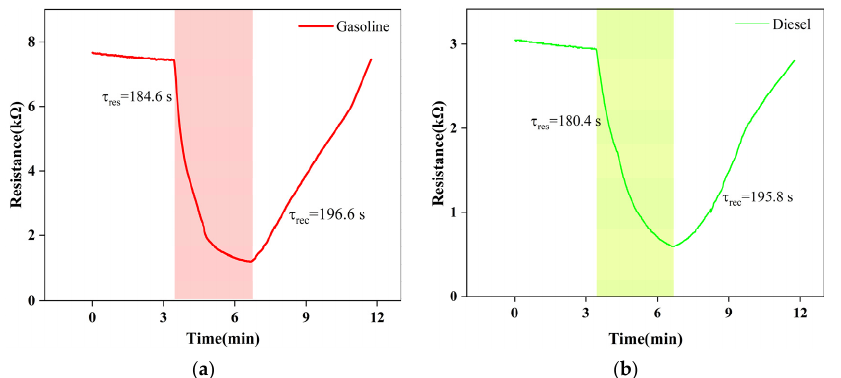
Figure 8. Response of Gd 0 . 5 In to 100 ppm of different test gases at 250 ° C .